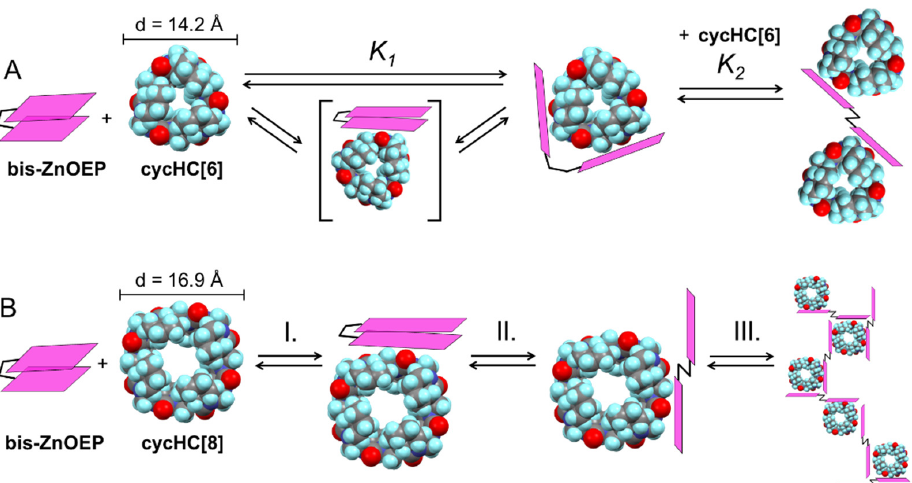
Figure 8. The proposed binding mechanisms of bis–ZnOEP with ( A ) cycHC[6] described by obtained association constants and with ( B ) cycHC[8]. The 3D structures and diameters of cycHC[ n ] s are based on previously reported crystal structures [36]. Color coding: C—gray, H—light blue, O—red, and N—dark blue.